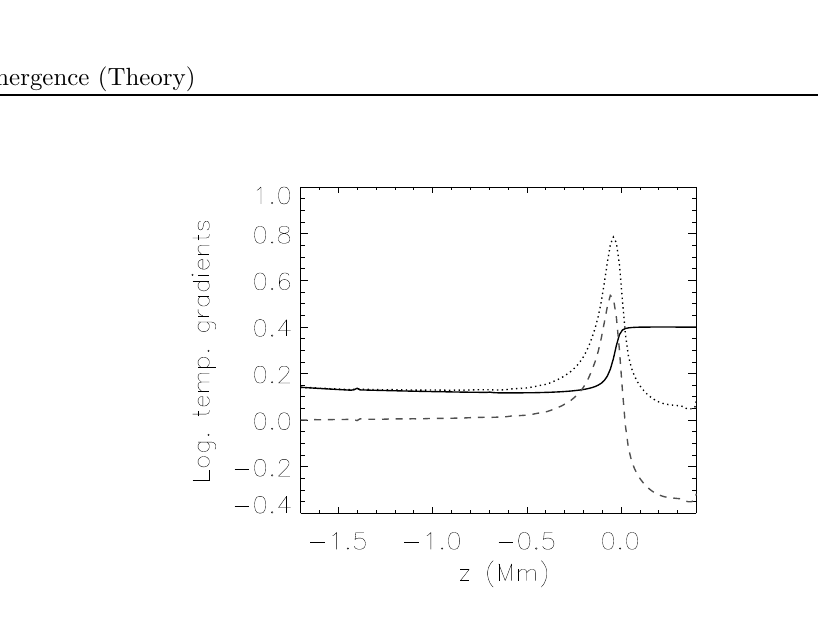
Figure 11: Horizontally-averaged logarithmic temperature gradients in a radiative hydrodynamic simu- lation of the near-surface layers of the convection zone and overlying photosphere. The solid line shows ∇ ad , the dotted line shows ∇ , and the dashed line shows 𝛿 = ∇ − ∇ ad . The photosphere has 𝛿 < 0 and is convectively stable. Image reproduced with permission from Cheung et al. (2007b), copyright by